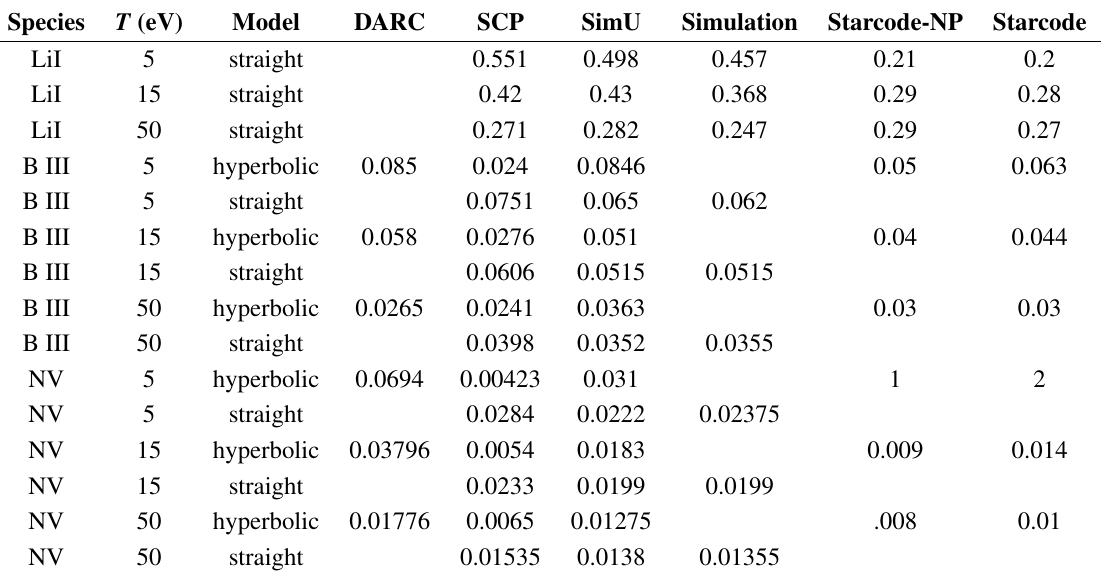
Table 3. 2s-2p Transition shift comparisons of all shifts are in cm − 1 and normalized to a density of 10 17 e/cm 3